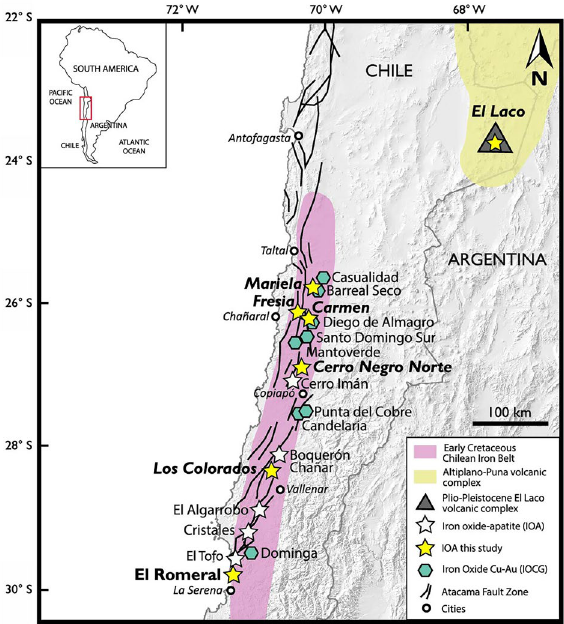
Figure 1. Location of the main iron oxide–apatite (IOA) deposits within the Early Cretaceous Chilean Iron Belt, and the Pleistocene El Laco volcanic complex in the Chilean Altiplano. Modified from Palma et al. 26